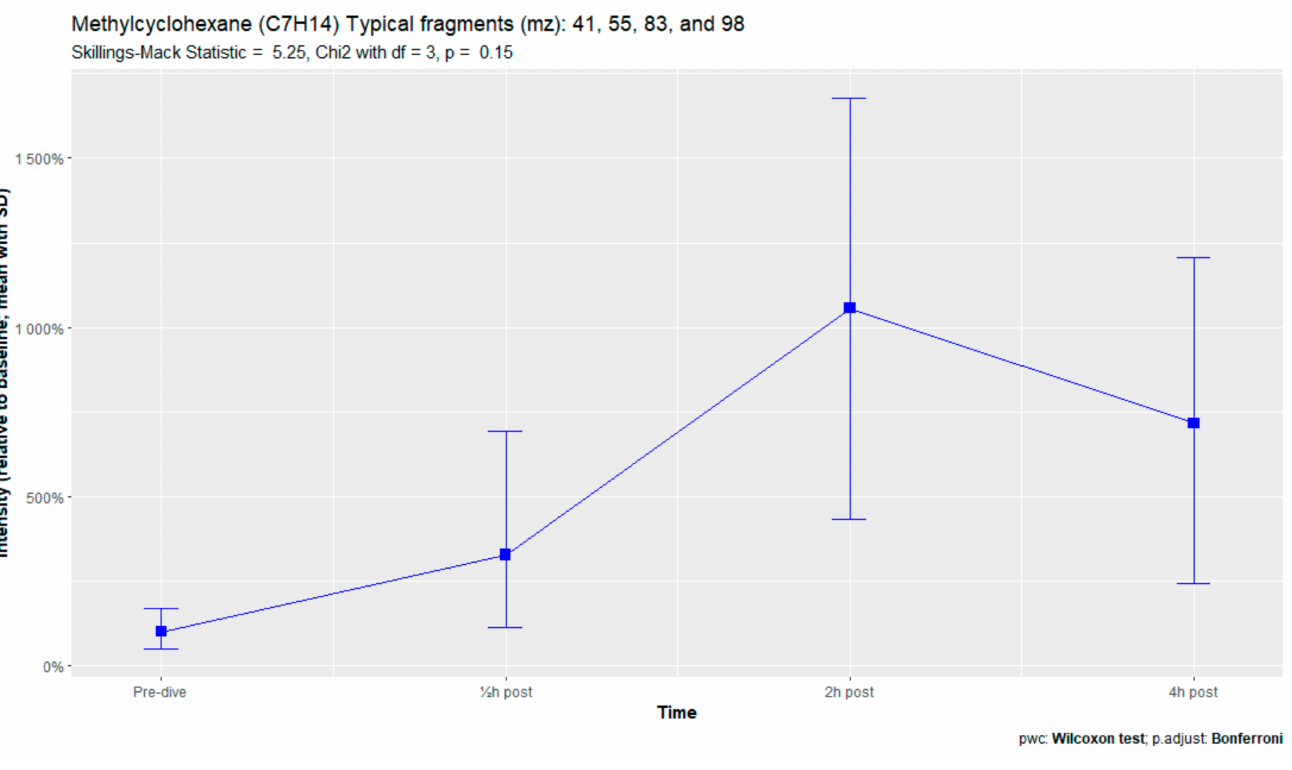
Figure A7. Methylcyclohexane.